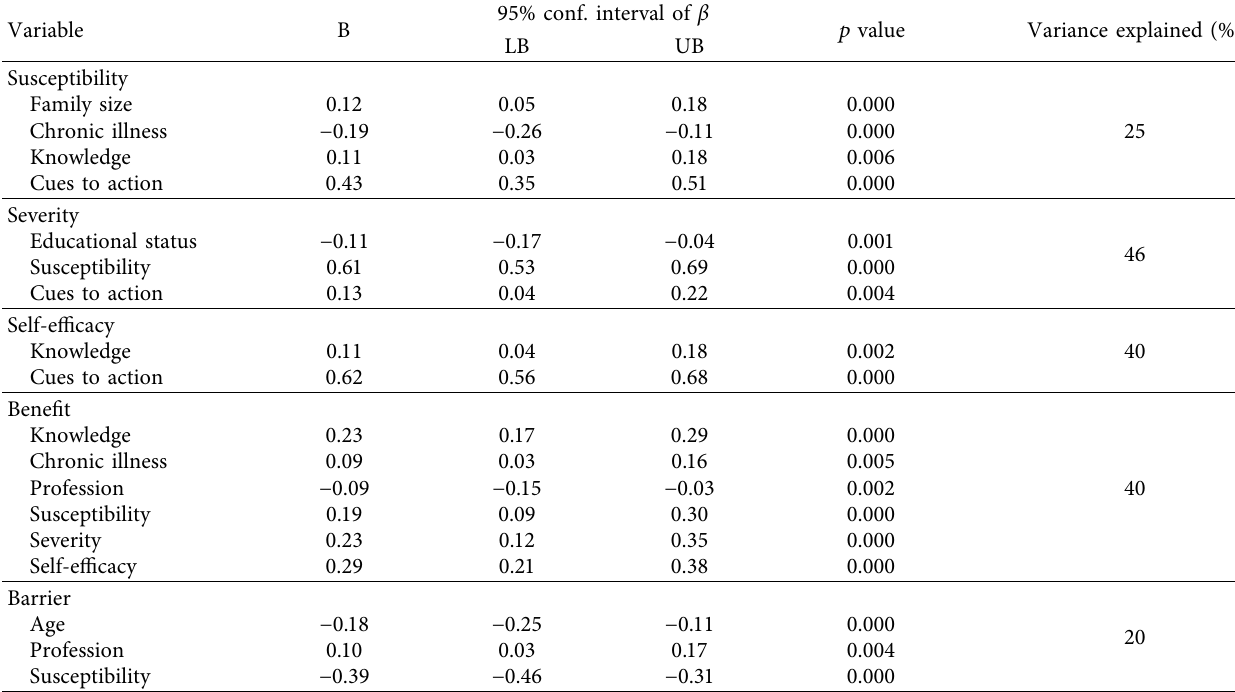
Table 3: Standardized regression weights of predictors of COVID-19-related perception among academic staff of the University of Gondar Ethiopia, April 2021 ( n � 602).